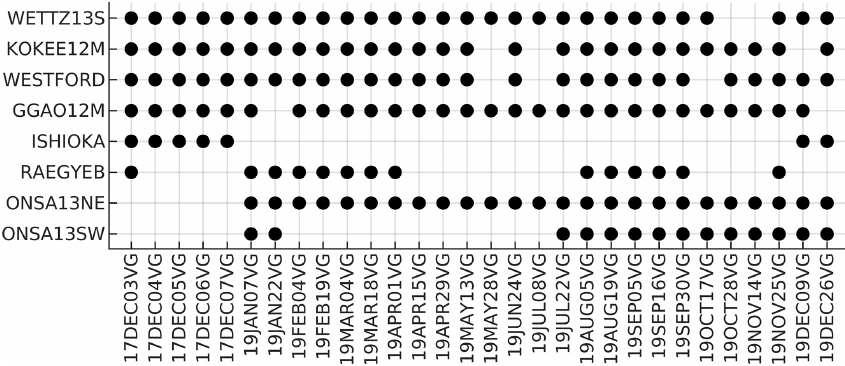
Figure 1. Station activity during the VGOS sessions used in this study. The first five sessions were part of the CONT17 campaign. ISHIOKA does only have VGOS observations during CONT17 and at the end of 2019. In between, it participated in S/X sessions.